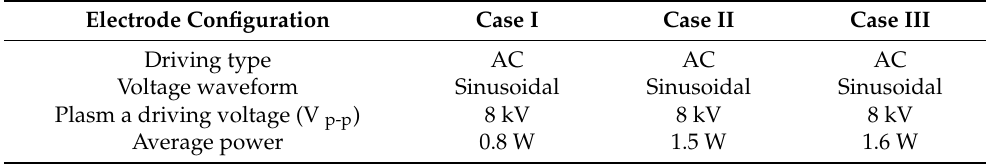
Figure 2. ICCD images of plasma produced in the APPR with pin electrode with respect to three different electrode configurations of cases ( a ) I, ( b ) II, and ( c ) III. Table 2. Summary of experimental results of the applied voltage and average power during plasma polymerization in APPR with three-pin electrodes used